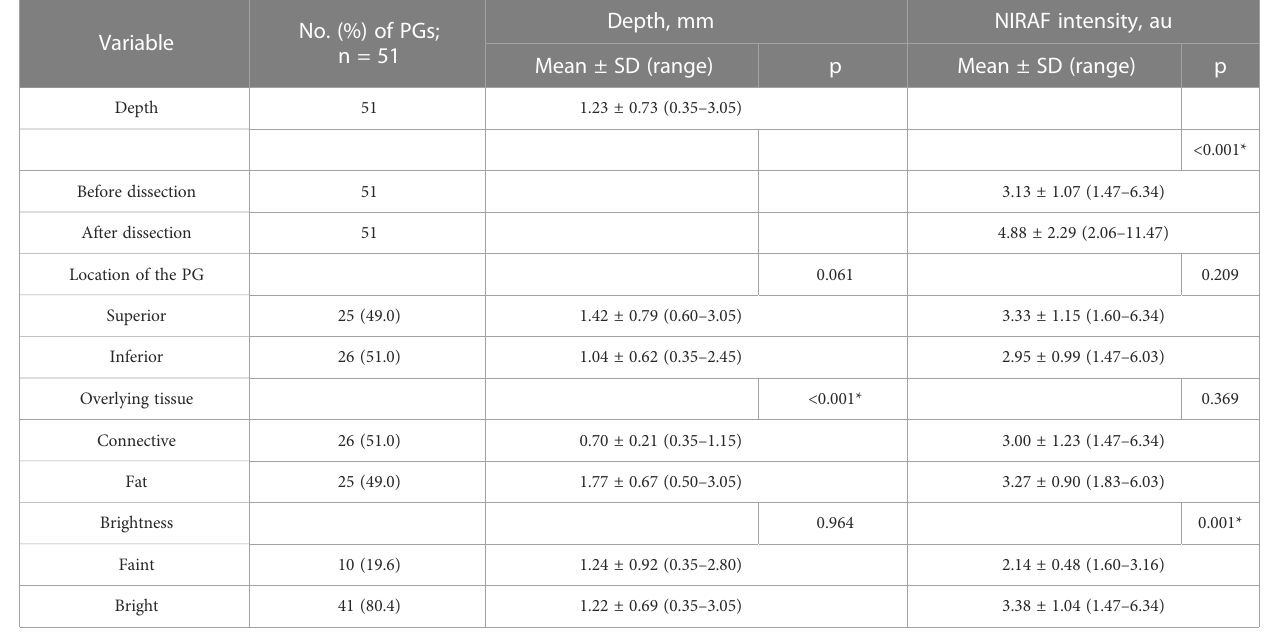
TABLE 1 Detectable depth and NIRAF intensity of unexposed